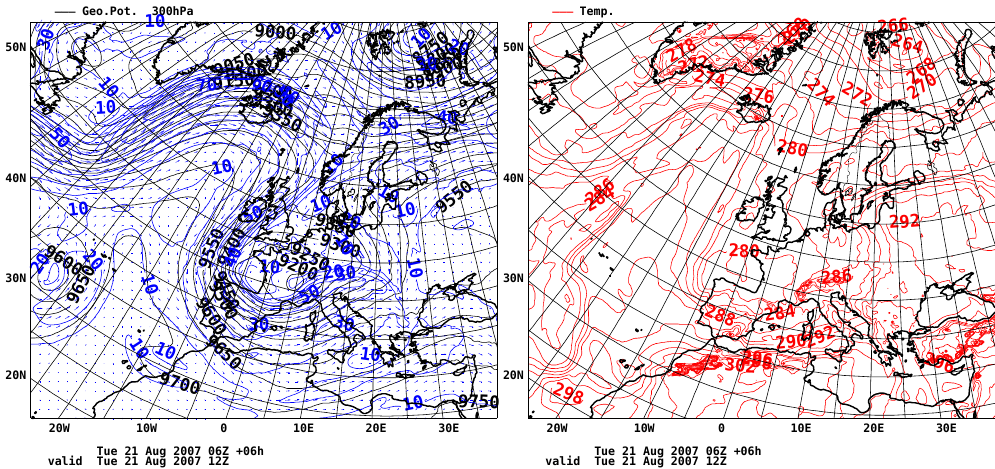
Fig. 3. 300 hPa wind and geopotential height (left) and 850 hPa temperature (right) taken from the background model state at 21 August 2007 06UTC + 6h; experiment based on equal static and ensemble contributions to the background error variance. Isoline spacing 50 m , 10 ms − 1 and 2 K .